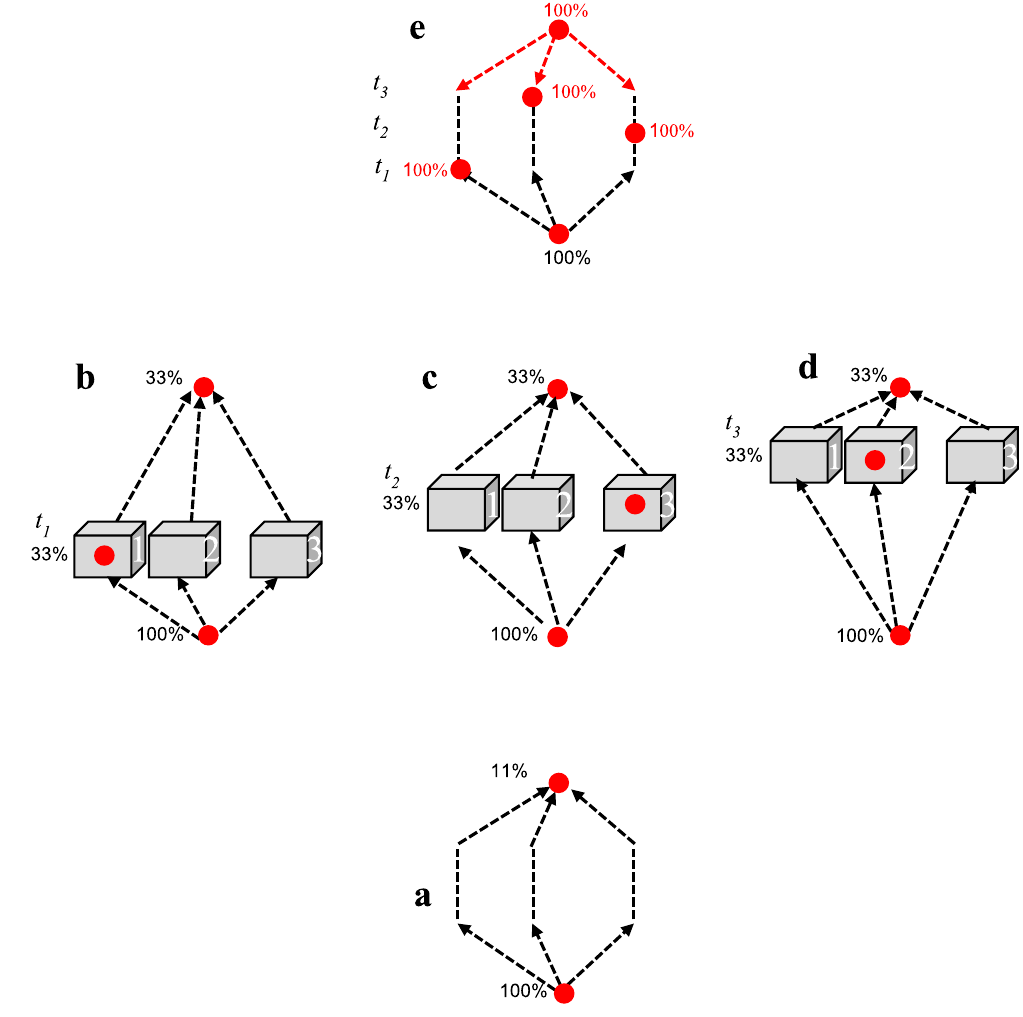
Figure 2. Possible time-evolutions of the experiment and the probabilities involved. ( a ) Only pre- and post- selections, without any intermediate measurement. ( b – d ) Pre- and post-selections with one intermediate measurement at either t 1 / t 2 / t 3 . ( e ) Counterfactual prediction for both t 1 , t 2 and t 3 (not performed) given both pre- and